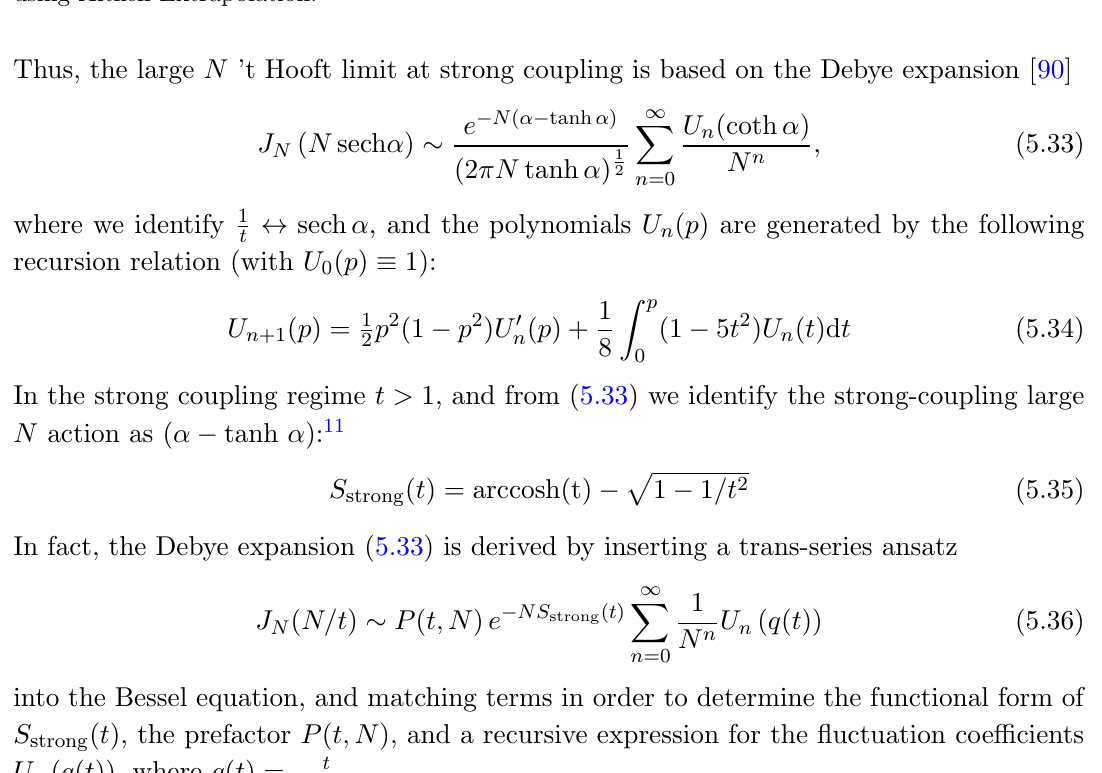
Figure 8 . Ratio of the exact perturbative coe(cid:14)cients d (0) n ( t ) from (5.24), divided by the resurgent large-order growth expression (5.31). Both plots are for t = 0 : 5, and include just the (cid:12)rst term in (5.31) [blue circles] or the (cid:12)rst two terms [gold squares]. Both sequences have been accelerated using Aitken